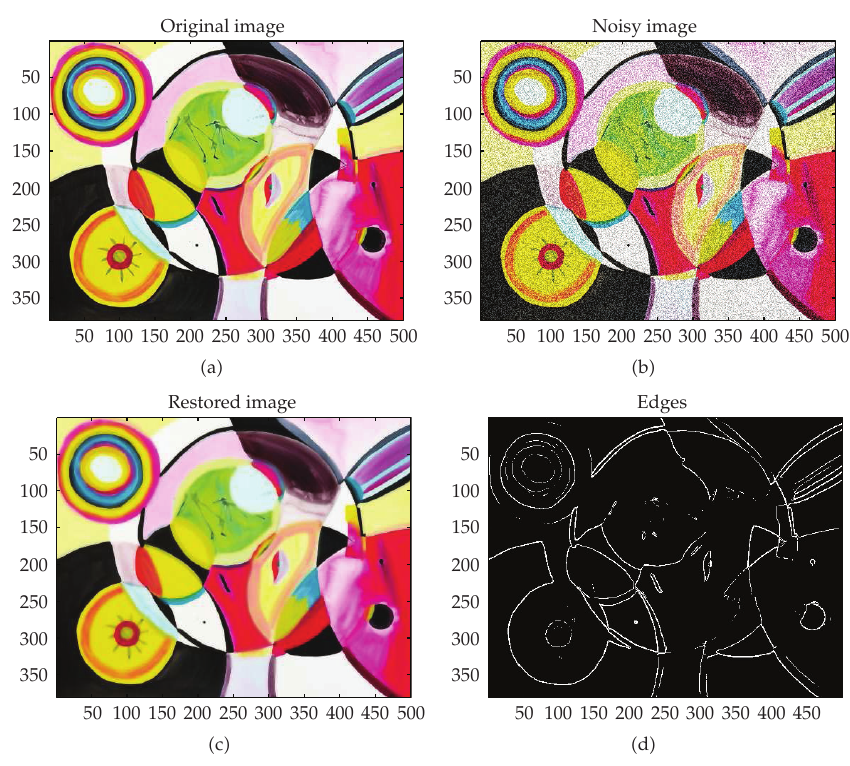
Figure 4: (cid:7) a (cid:8) the initial 500 × 380 image, (cid:7) b (cid:8) noisy image, (cid:7) c (cid:8) the restoredimage, and (cid:7) d (cid:8) edges of the restored